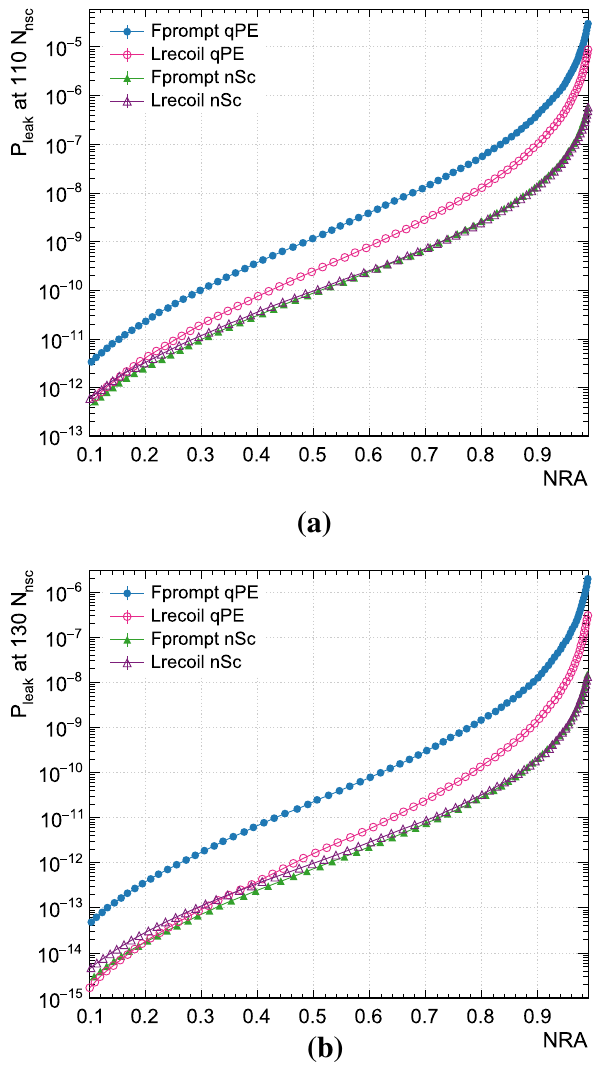
Fig. 5 Leakage probabilities for each PP as a function of NRA for events at a 110 N nsc (approximately 17.46 keV ee to 17.61 keV ee ) and at b 130 N nsc (approximately 19.65 keV ee to 19.82keV ee ). Statistical error bars, where not visible, are smaller than the marker size